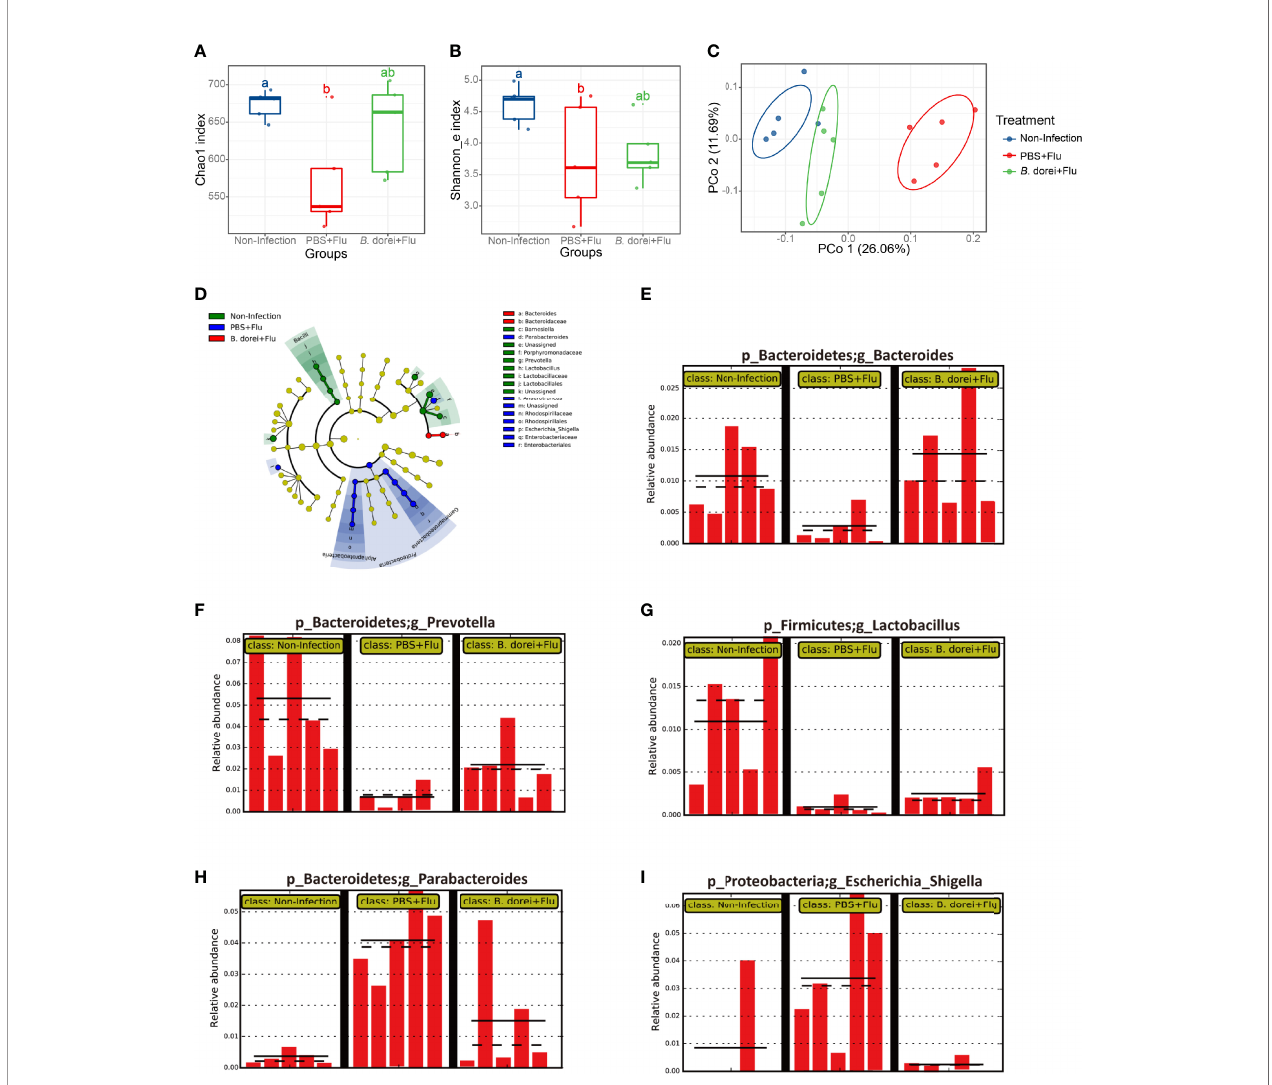
FIGURE 7 | Effects of B. dorei on diversity and composition of gut microbiota of in fl uenza-infected mice. (A) Chao1 index. (B) Shannon_e index. (C) The PCoA plot based on unweighted UniFrac metrics. (D) LEfSe taxonomic cladogram. (E-I) represent the relative abundance of the genus of Bacteroides, Prevotella, Lactobacillus, Parabacteroides, and Escherichia_Shigella by LEfSe analysis with a threshold of P = 0.05, respectively. Groups followed by the same letters are not signi fi cantly different according to Tukey ’ s HSD test (A, B) . The PCoA was compared with nonparametric MANOVA based on Adonis (P <